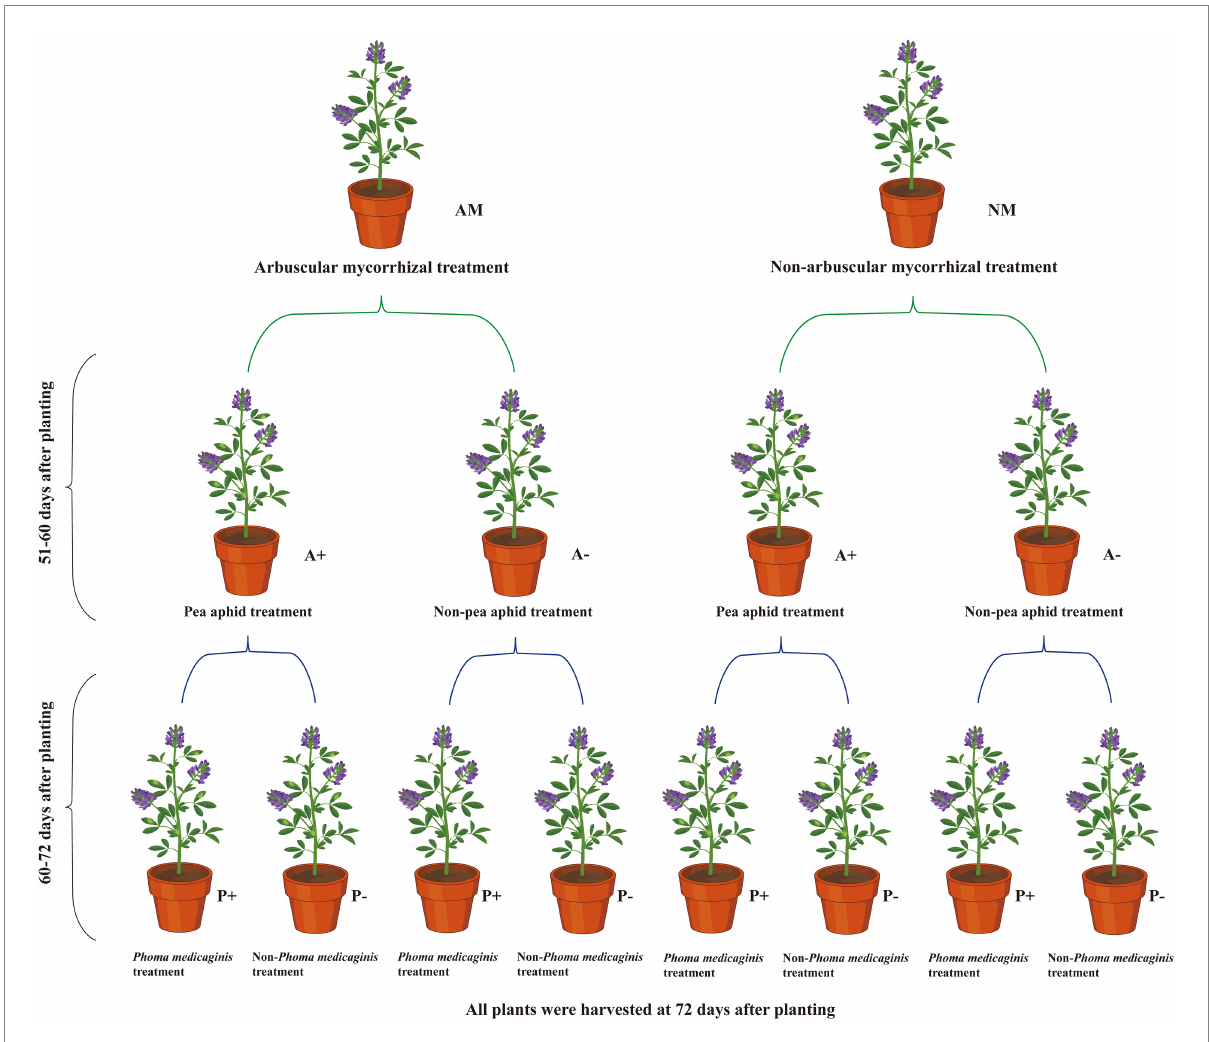
FIGURE 1 Flow chart showing the experimental design of the